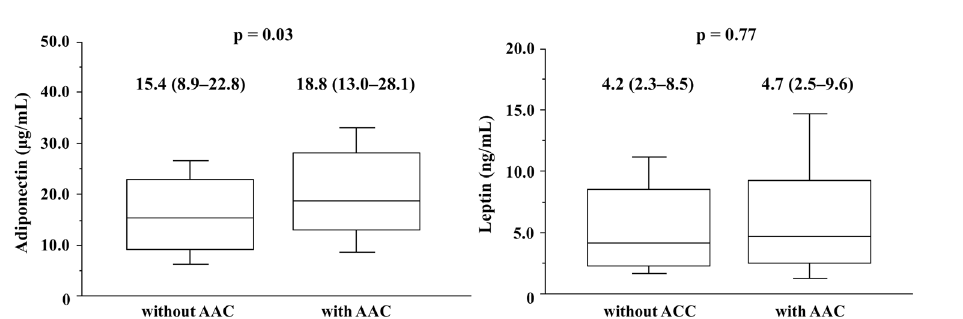
Table 1. Clinical and biochemical characteristics of the study patients. Values are expressed as mean ± standard deviation, number, or median (Q 1 –Q 3 ). Conversion factors for units—calcium (mg/dL to mmol/L): × 2.2495, phosphate (mg/dL to mmol/L): × 0.3229. AAC: abdominal aortic calcification, PTH: parathyroid hormone, hs- CRP: high-sensitivity C-reactive protein.